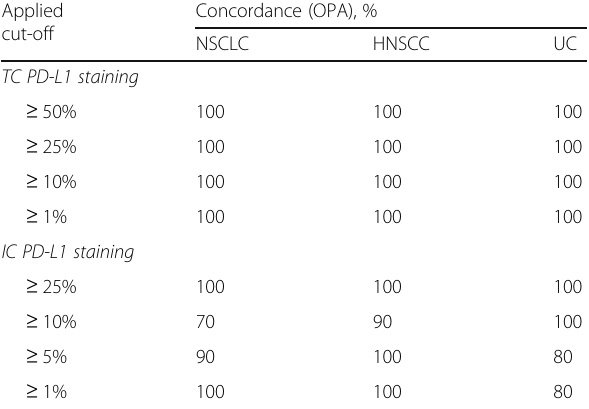
Table 3 Intra-block concordance (OPA) in PD-L1 classification at various applied cut-offs Applied cut-off